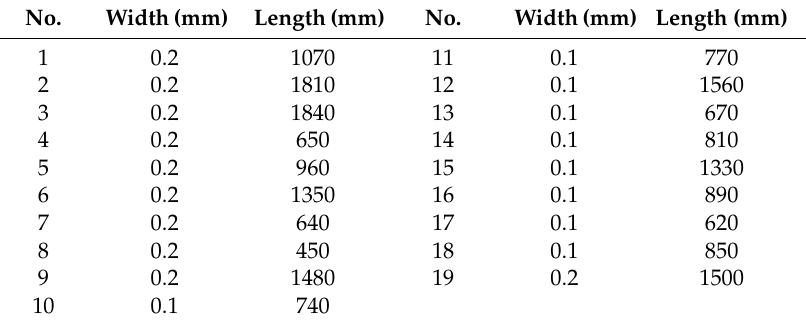
Table 2. The width and approximate length of cracks.